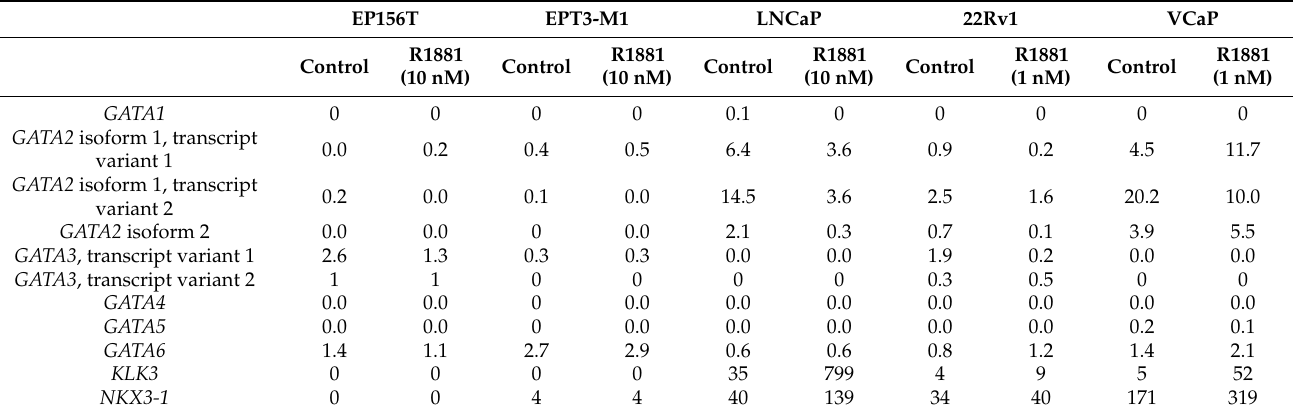
Table 1. RNA-seq expression of selected genes in prostate benign and cancer cell lines. EP156T EPT3-M1